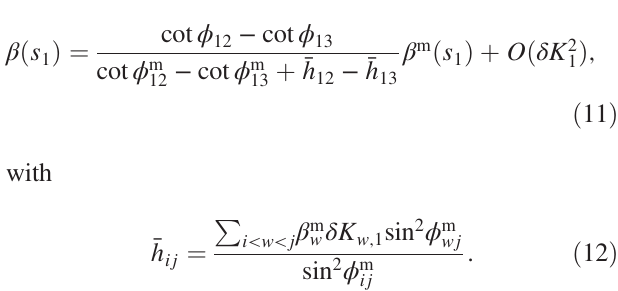
FIG. 2. Top: Difference between the real (simulated) horizontal β -functions and the ones calculated by Eq. (1) in red and (11) in blue, respectively. Data are from MADX simulations of a lattice with quadrupolar errors only. Bottom: The same quantities are evaluated for the case with additional magnet misalignments. rms denotes the root mean square of the deviations and p-t-p denotes peak-to-peak